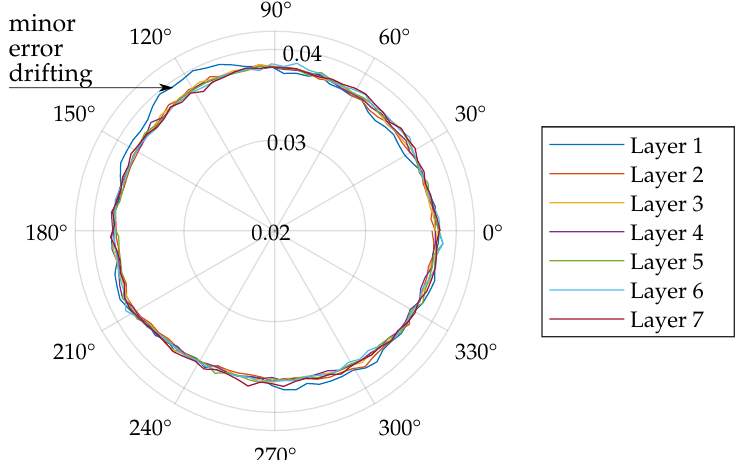
Figure 19. Root mean square (RMS) error of all registration operations with respect to each vertical layer and radial